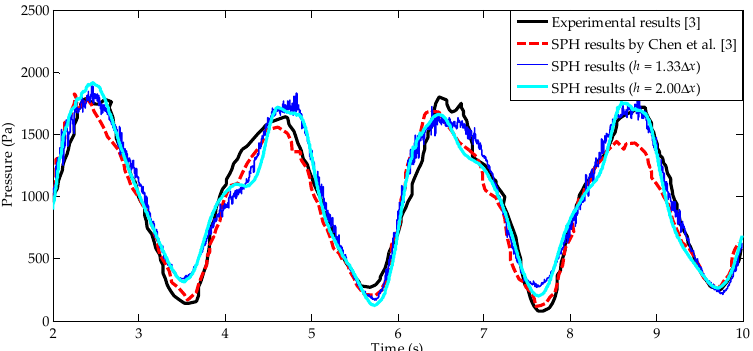
Figure 21. Pressure value on the solid boundary obtained by the SPH simulations and the experiment ( ω = 0.95 rad/s ) .